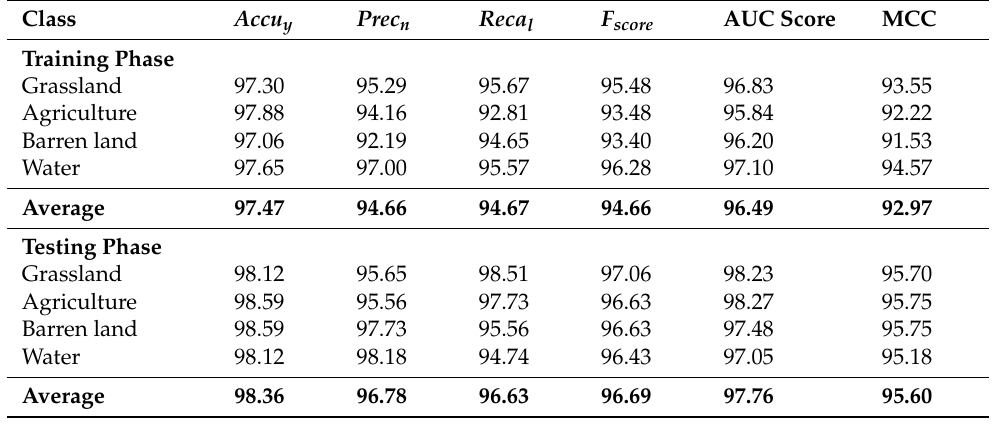
Table 2. Classification outcome of TSADL-LULCCD approach on 80:20 of TR/TS databases.